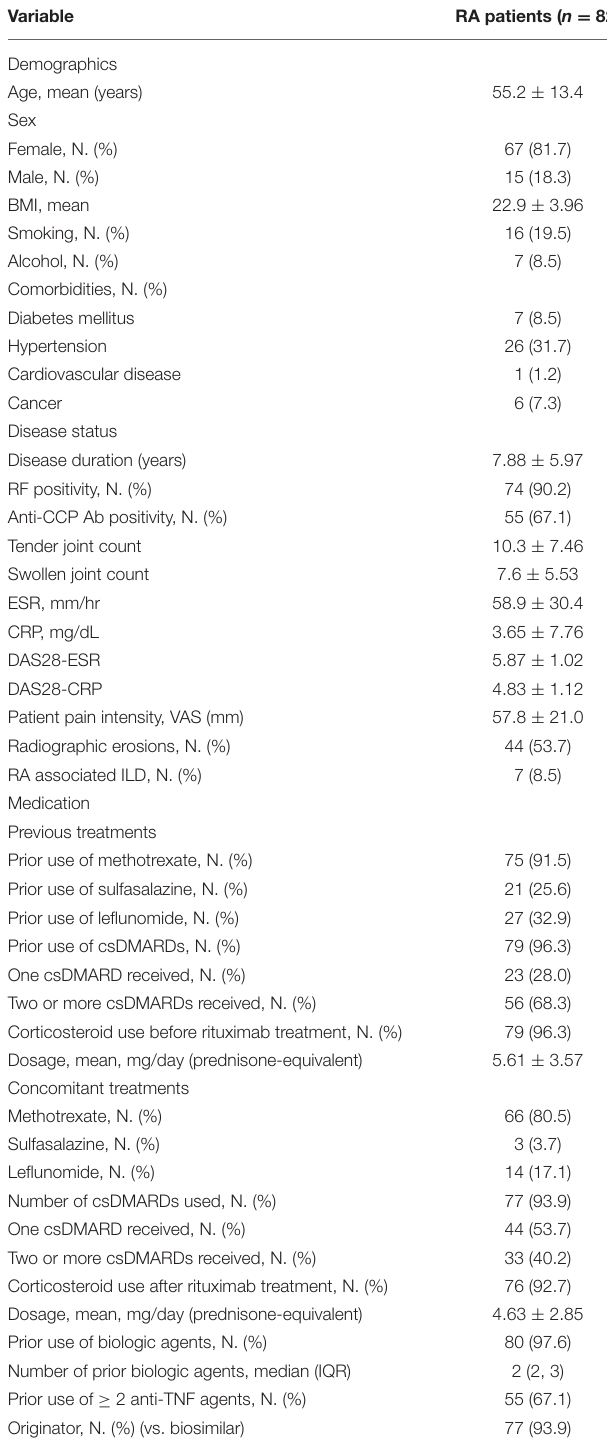
TABLE 1 | Baseline characteristics of patients with RA at time of first cycle of